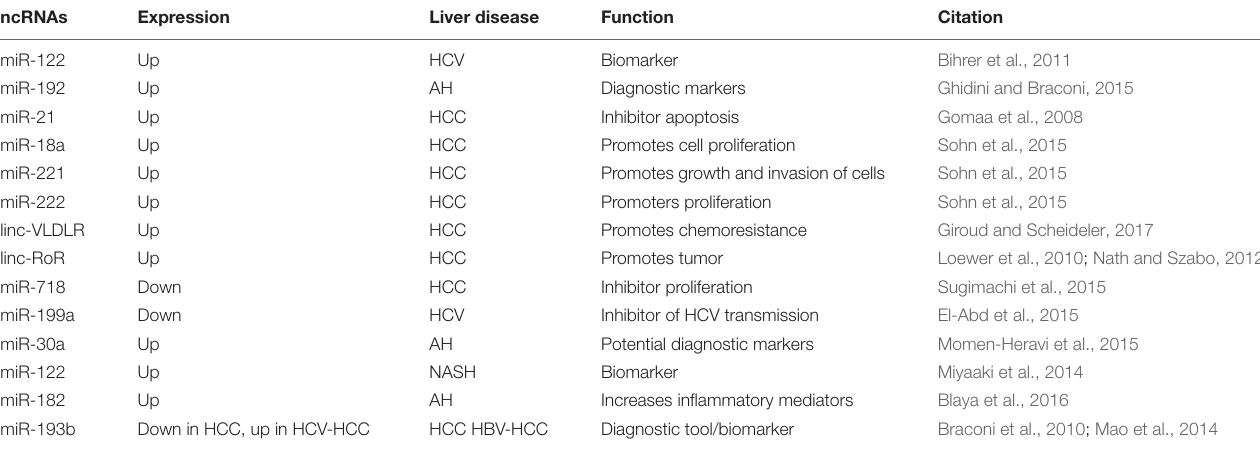
TABLE 2 | EV-associated ncRNAs in liver